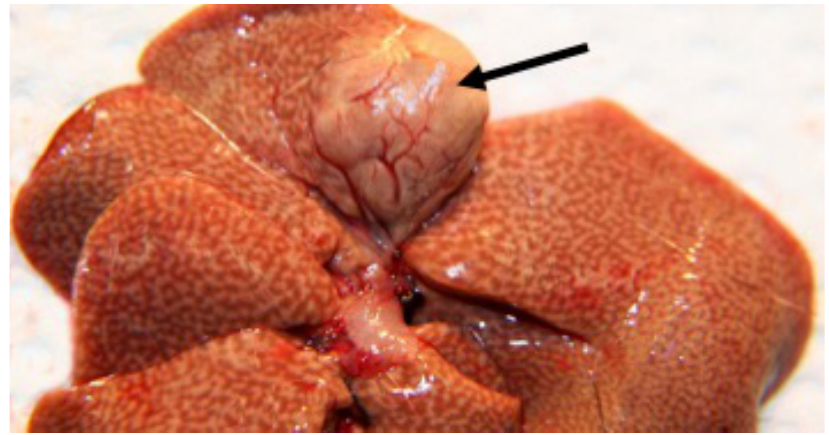
Figure 7. Reticulated pattern typical of fatty liver infiltration with prominent hepatic cell carcinoma (arrow) in chronic T2DM of more than a year’s duration.